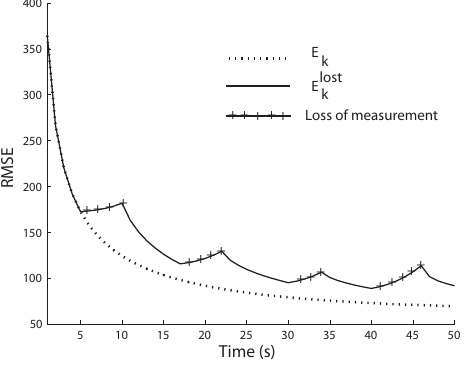
Figure 2. Variation of the RMSE of the estimated state with and without measurement